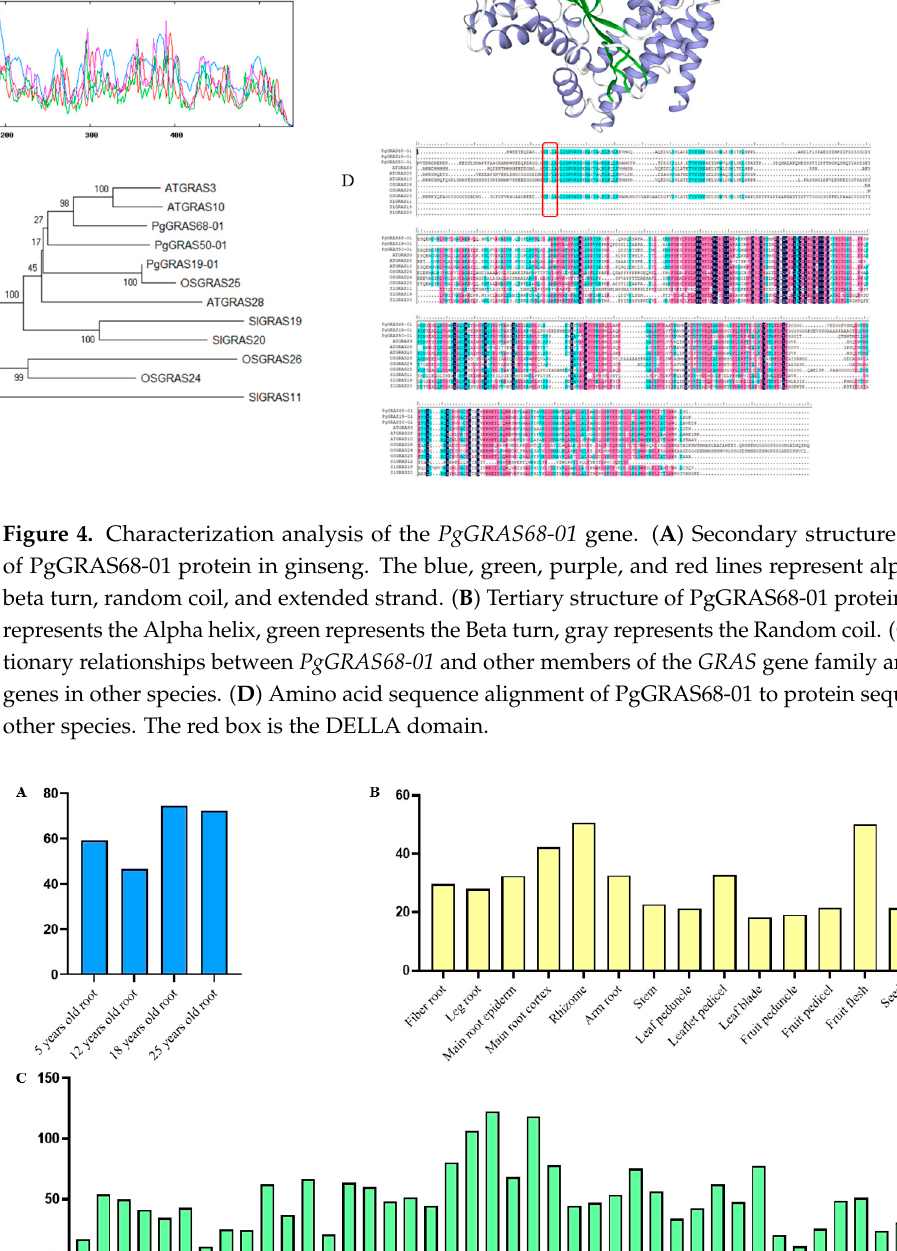
Figure 4. Characterization analysis of the PgGRAS68-01 gene. ( A ) Secondary structure analysis of PgGRAS68-01 protein in ginseng. The blue, green, purple, and red lines represent alpha helix, beta turn, random coil, and extended strand. ( B ) Tertiary structure of PgGRAS68-01 protein. Purple rep- resents the Alpha helix, green represents the Beta turn, gray represents the Random coil. ( C ) Evolu- tionary relationships between PgGRAS68-01 and other members of the GRAS gene family and GRAS genes in other species. ( D ) Amino acid sequence alignment of PgGRAS68-01 to protein sequences of other species. The red box is the DELLA domain.